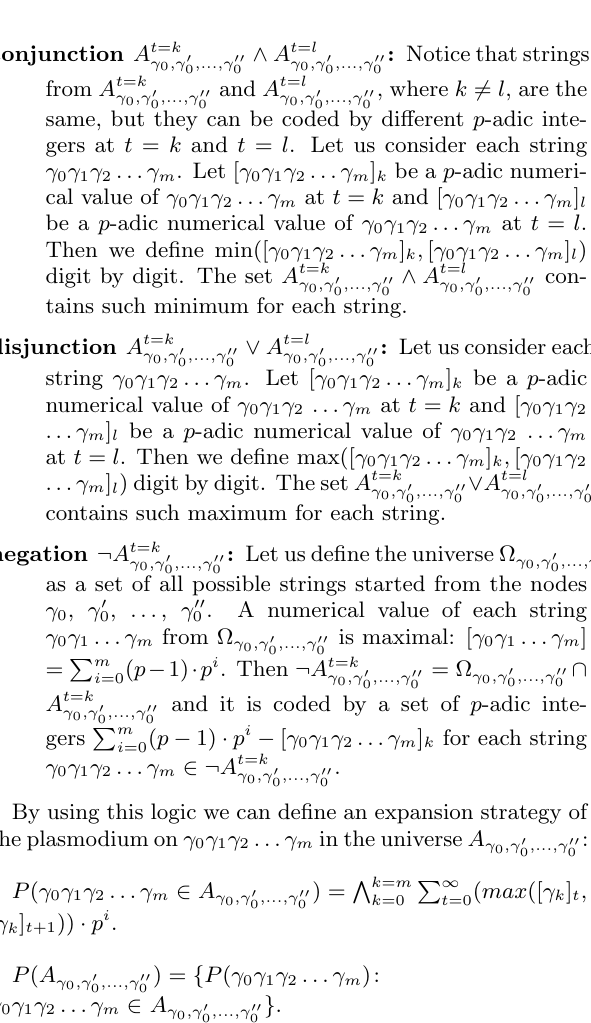
Figure 4: At each step of plasmodium propaga- tion, there are not more than four attractants which can be occupied. At the time step t > 0 the plas- modium expansion is coded by the 4-adic integer . . .